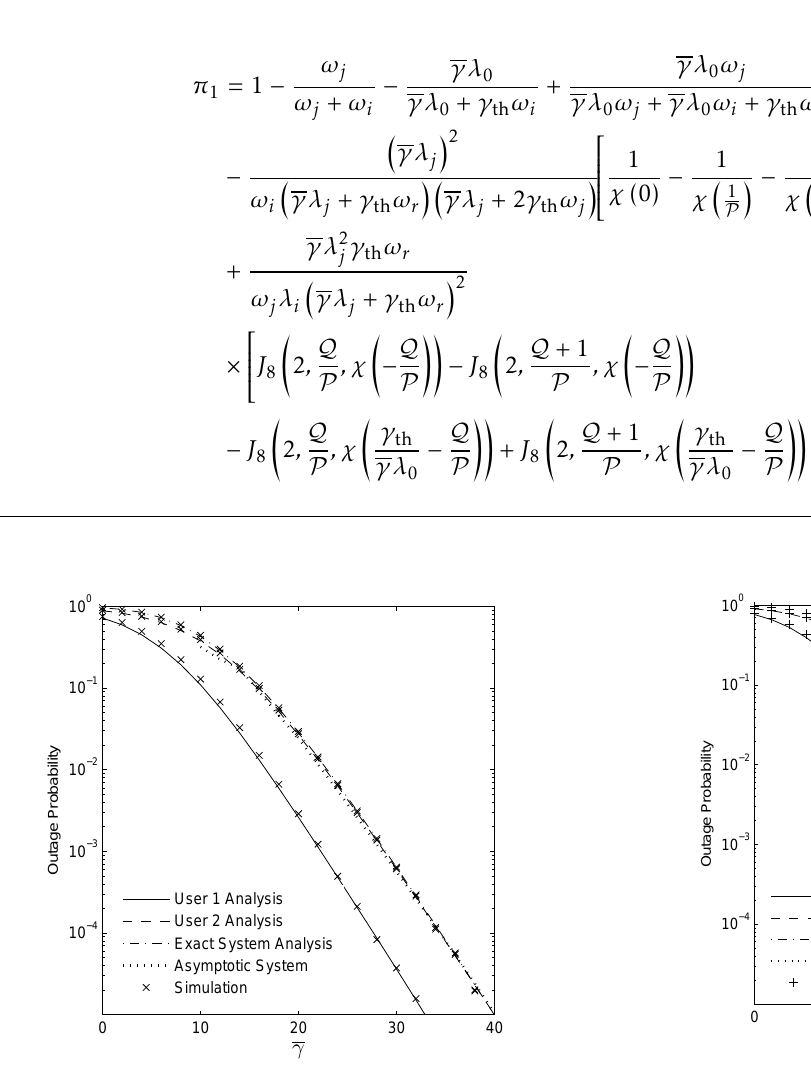
Figure 3. Outage Probability of SC vs γ with R = 1 and η = 3